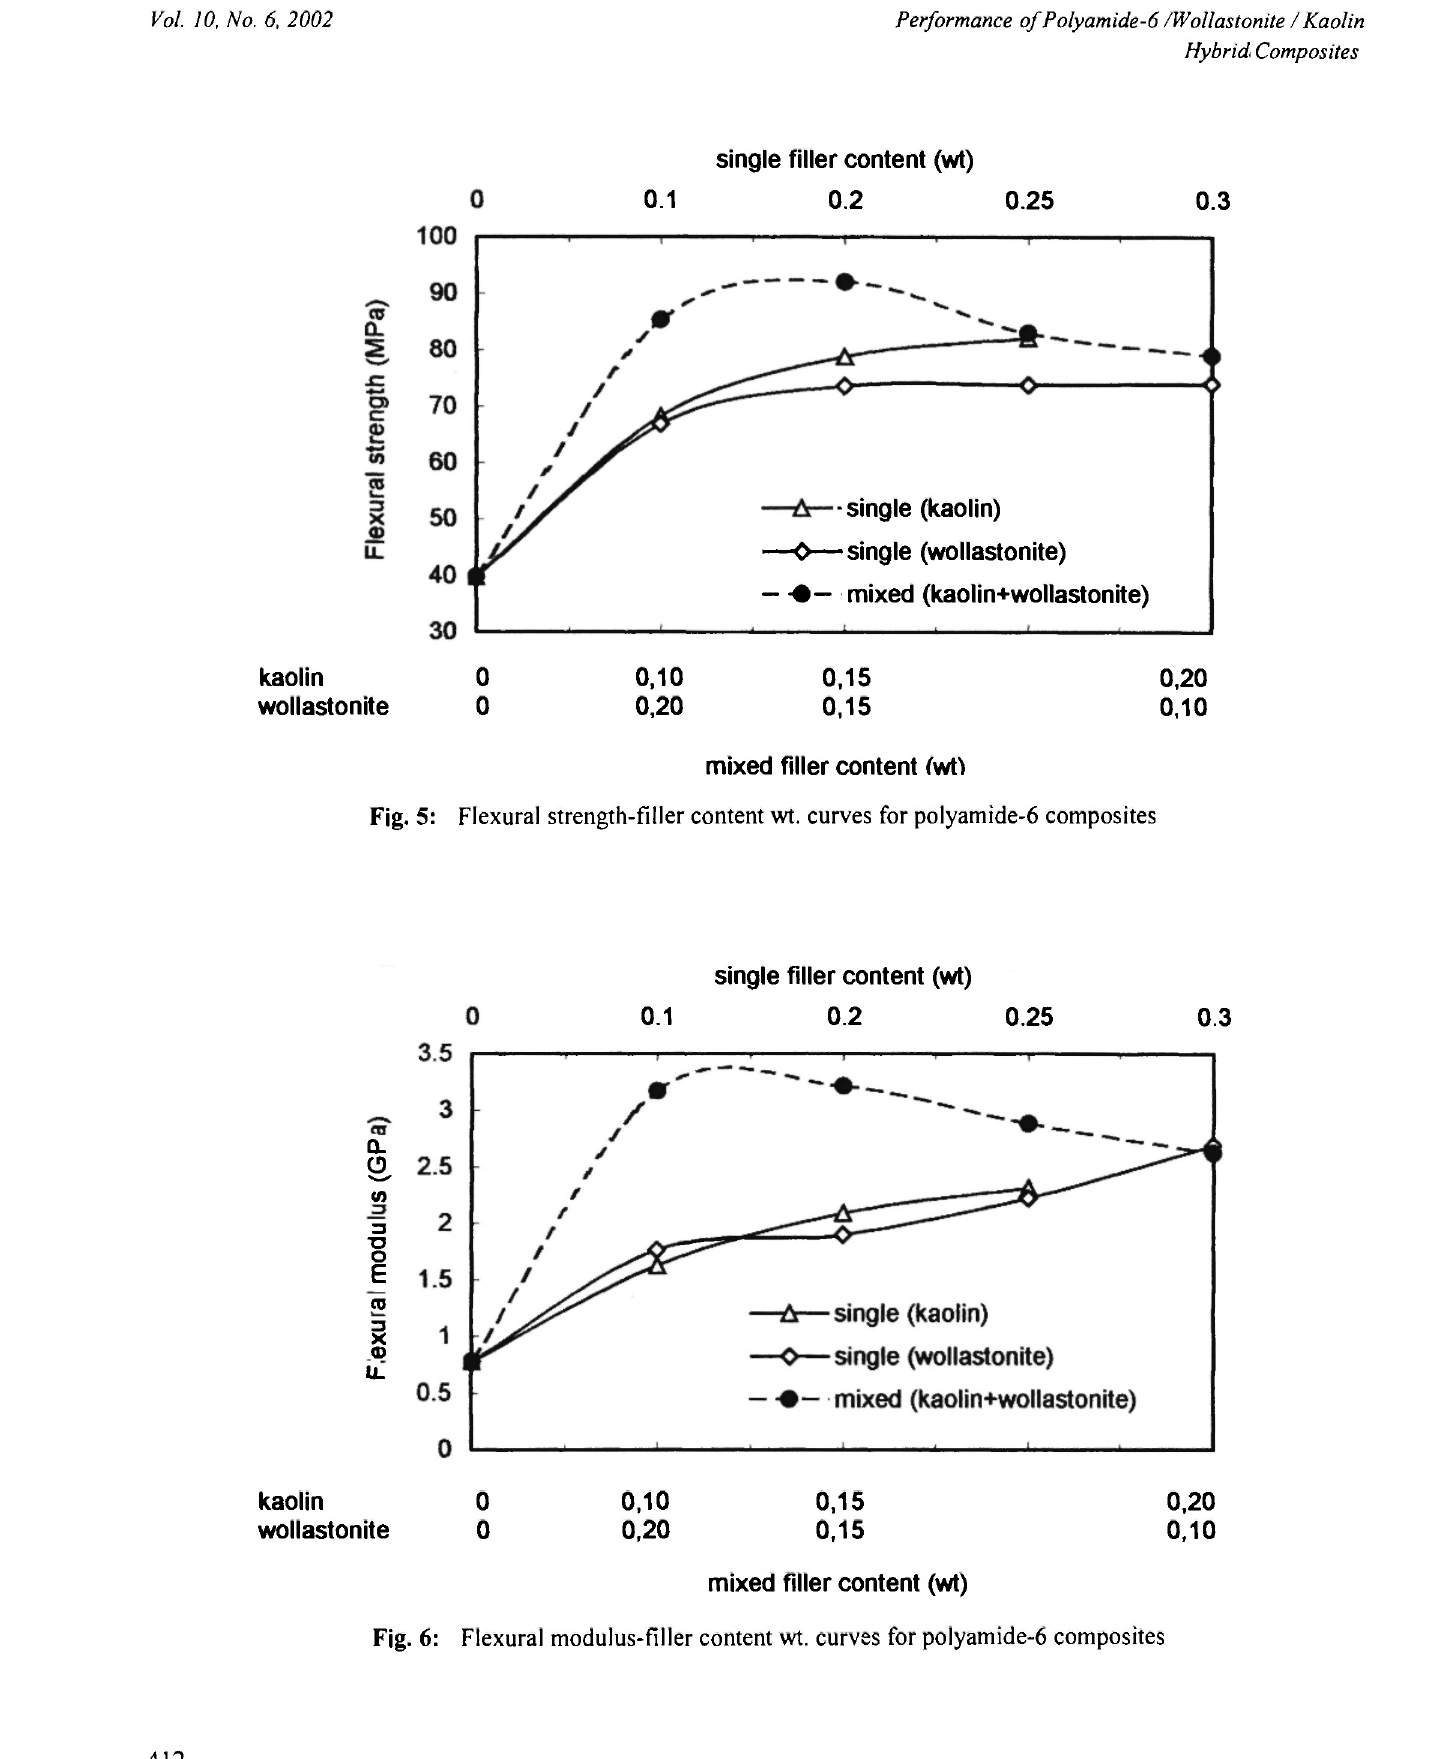
Fig. 6: Flexural modulus-filler content wt. curves for polyamide-6